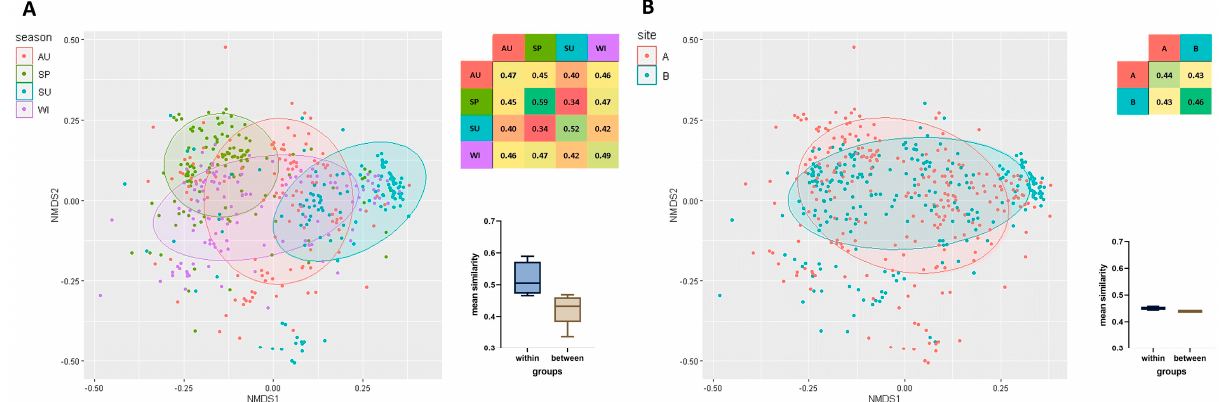
Figure 2. Non-metric multidimensional scaling (NMDS) based on a matrix of clonal similarity of bacterial strains, including a 95% confidence ellipse. Each point represents one bacterial isolate. A heatmap of similarities within and between the studied groups is presented. The barplot (Box- Whisker Plot) of average similarity within and between groups (whiskers denote minimum and maximum values) and the box represent the second and third quartile with the median bar inside. The results are presented for each season ( A ) and sampling site ( B ). Legend: AU—autumn,